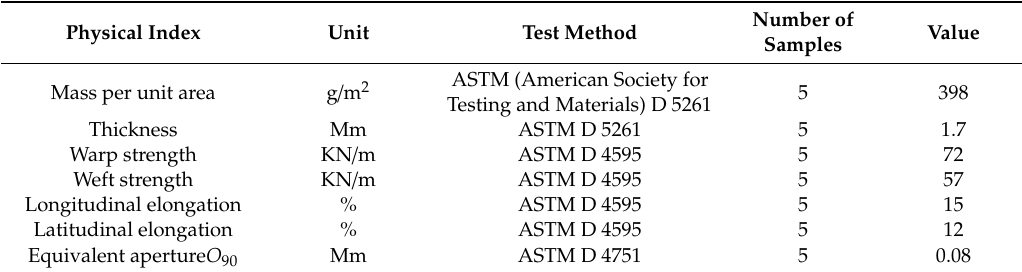
Table 1. Parameters of polypropylene woven fabrics.